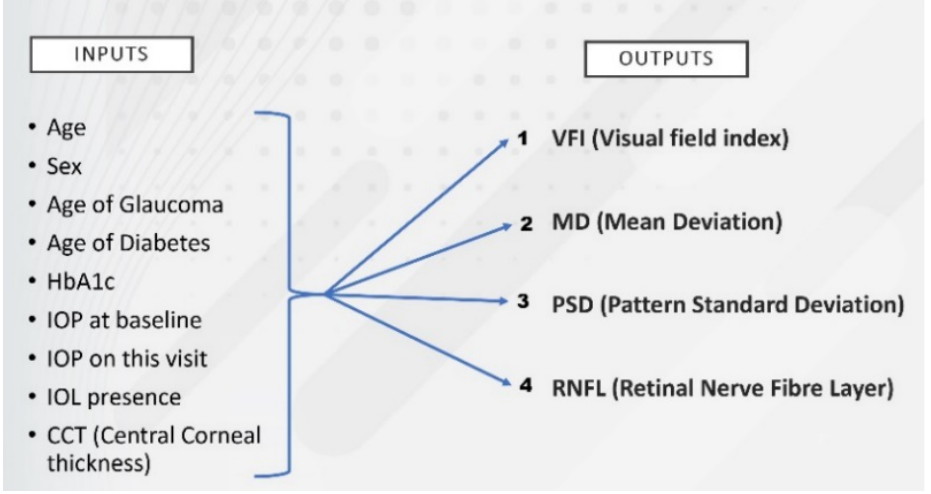
Figure 1. Inputs and outputs considered in the 4 problems created to predict glaucoma evolution. Secondly, a modified version of the same dataset was used (called dataset 2), in which the 3 visits were assigned to the same patient, the problem created for predicting the progression of glaucoma involved 12 inputs and one output, as shown in Figure